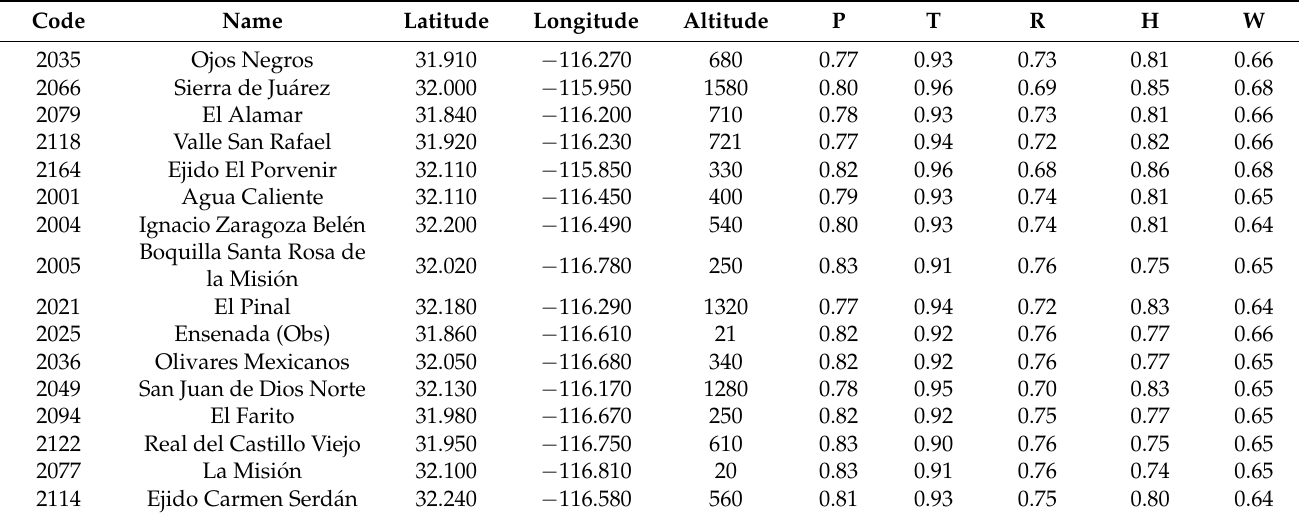
Table 1. Stations and variables of P, T, R, H, and